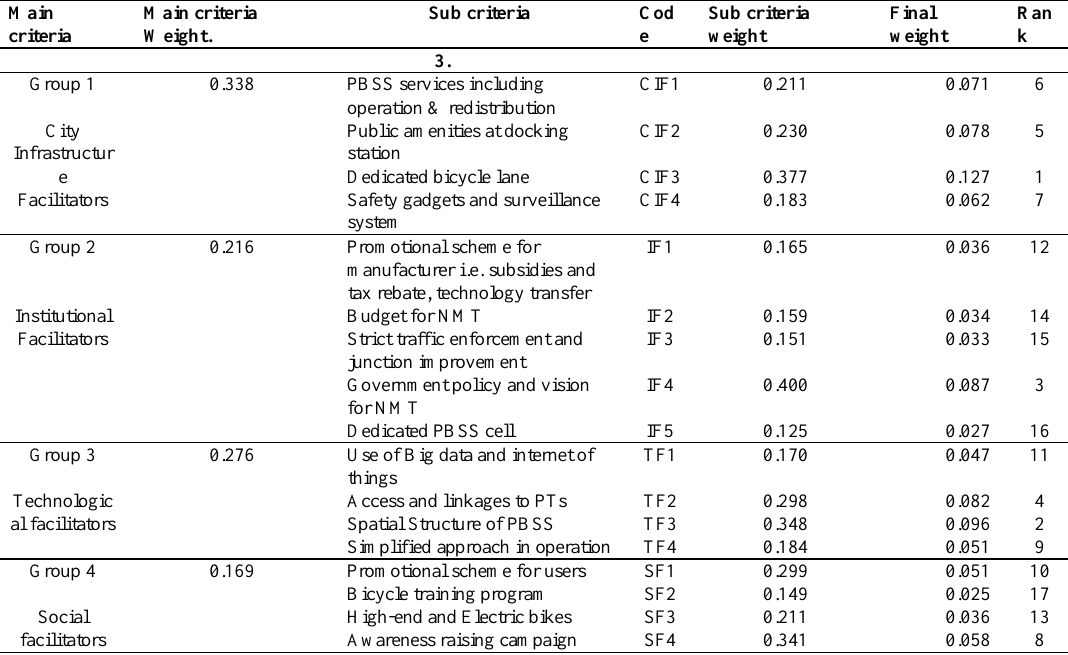
Table 5. Final weight for main criteria and sub